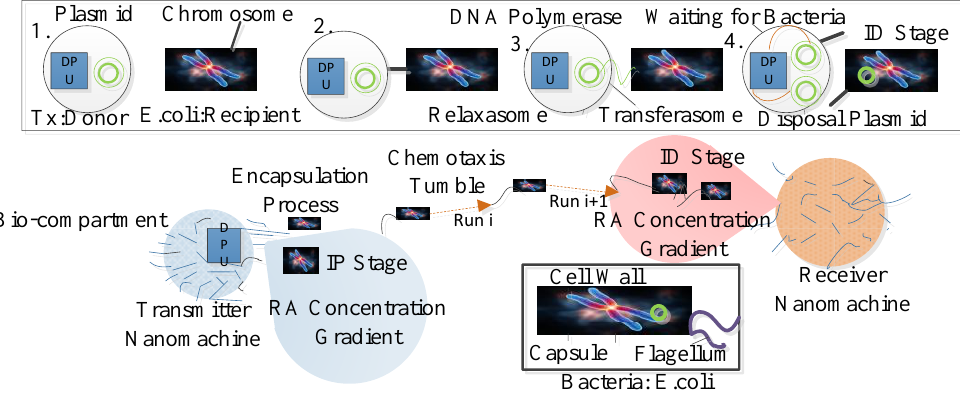
Figure 16. Communication stages of molecular communication using bacteria relay.